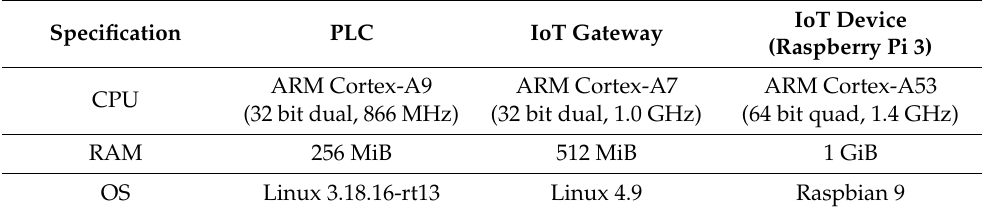
Table 2. IIoT devices for security information